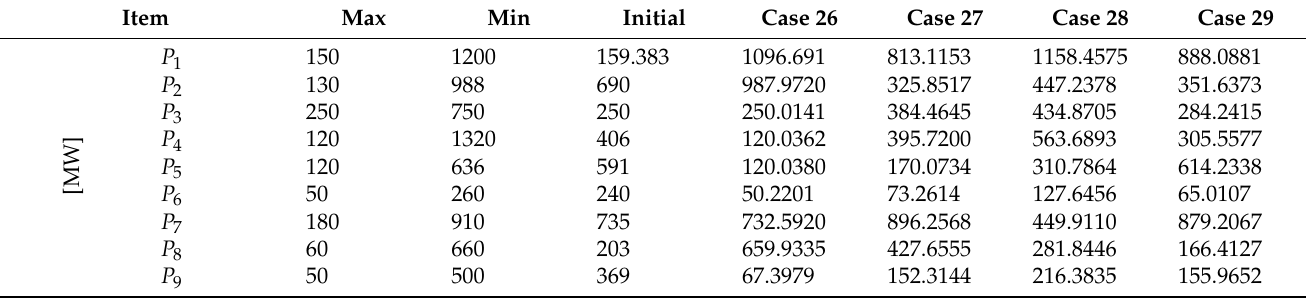
Table 10. Optimal control variables obtained by the SMA for four cases on the ISGHV